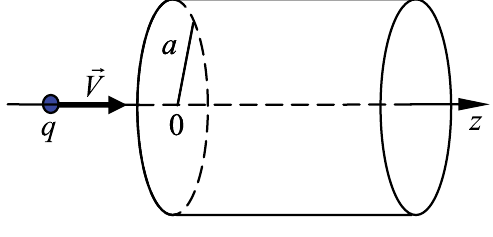
FIG. 1. The geometry of the